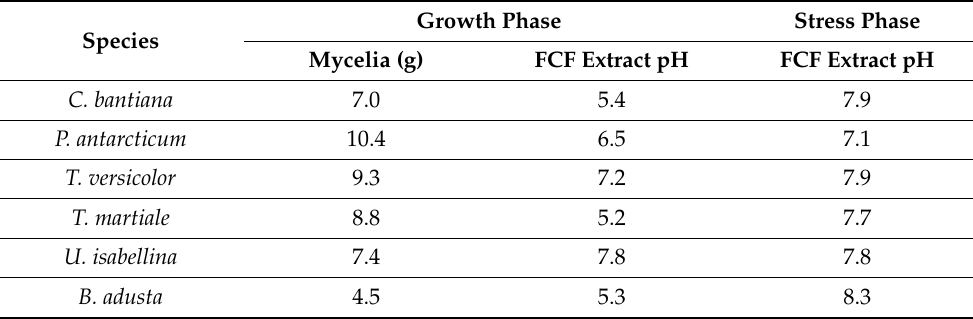
Table 1. Mycelia weight and FCF extract pH of each fungus in the growth phase (MYGP medium) and FCF extract pH after the stress phase (sterile deionised water).